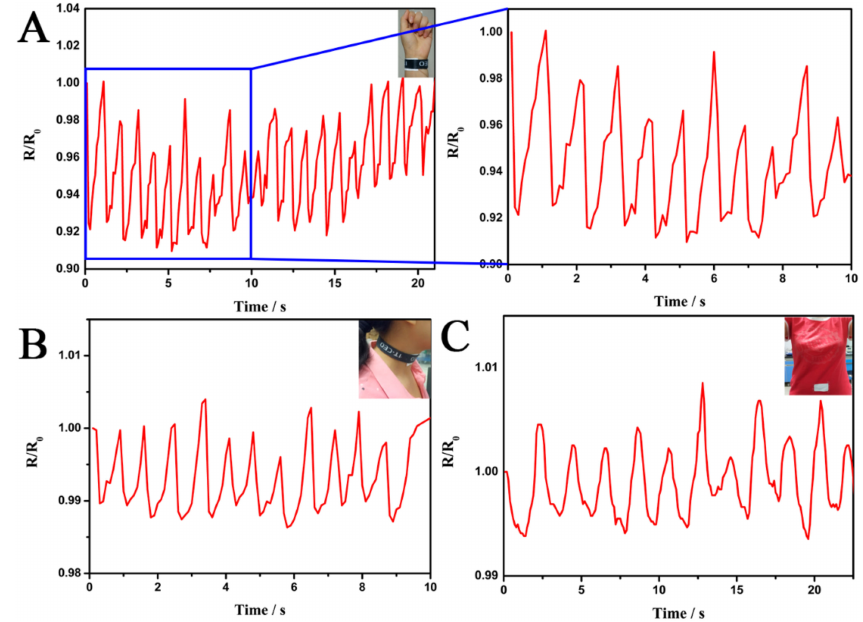
Figure 6. Real-time measurements of human wrist pulse ( A ), neck pulse ( B ) and respiration rate ( C ) using the nanofiber mats-based piezoresistive sensor. Insets: Attachments of the sensor on the volunteer’s wrist, neck, and abdomen,